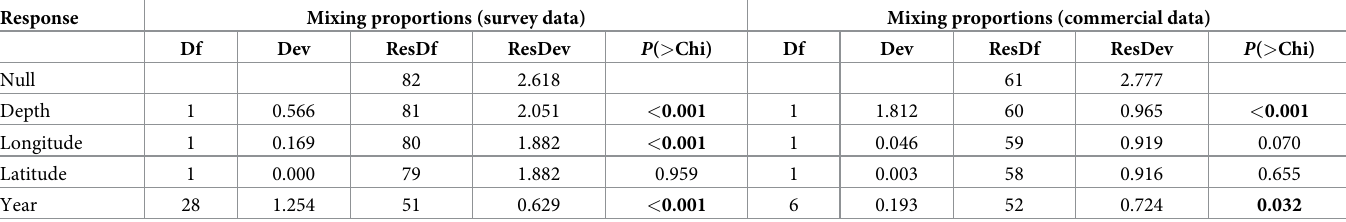
Table 1. GLMs containing stock mixing proportions of survey and commercial data as Gaussian response variable and mean depth, longitude, latitude and capture year of fishing hauls as predictors.